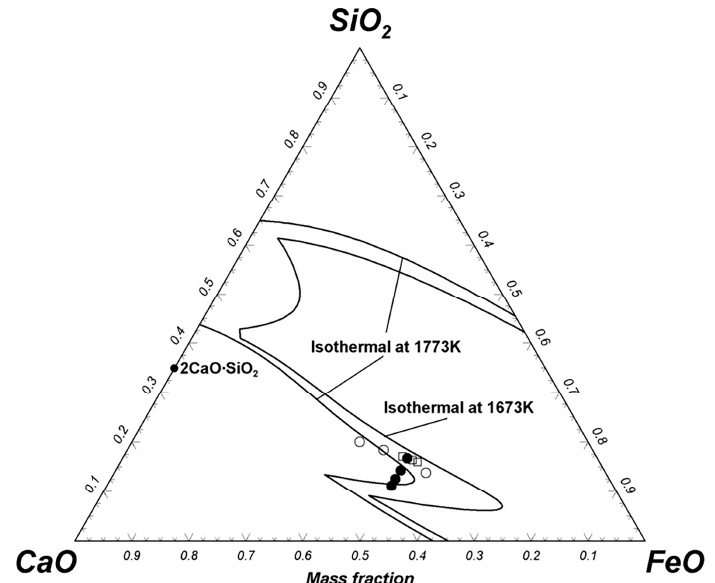
Figure 1. Position of the slag composition in the liquidus diagram of the CaO-FeO-SiO 2 ternary system at 1400 °C and 1500 °C.